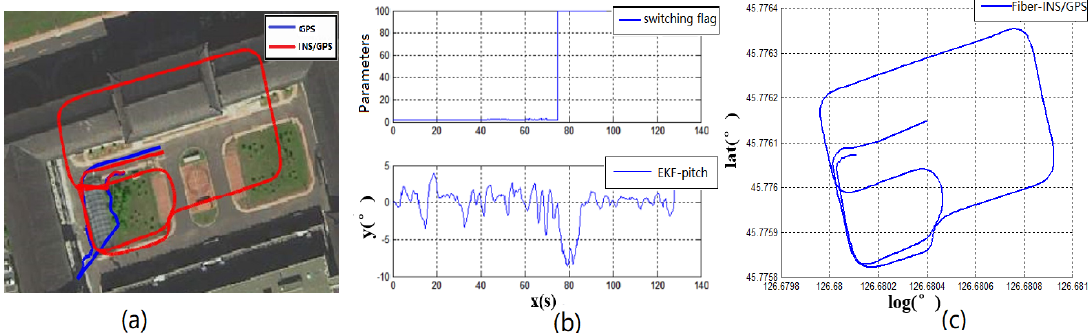
Figure 7. Experiment 2 test